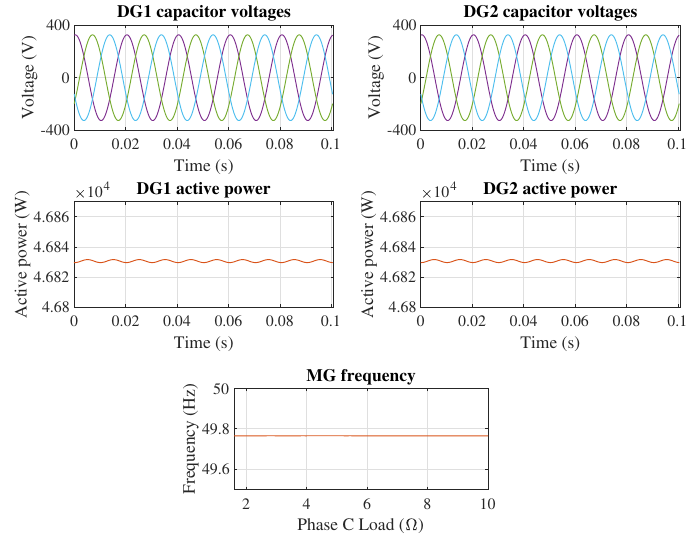
Figure A2. Time-domain simulation of five full-cycles of the computed solution in Case 2. Addition- ally, the system frequency during the whole phase C load variation.